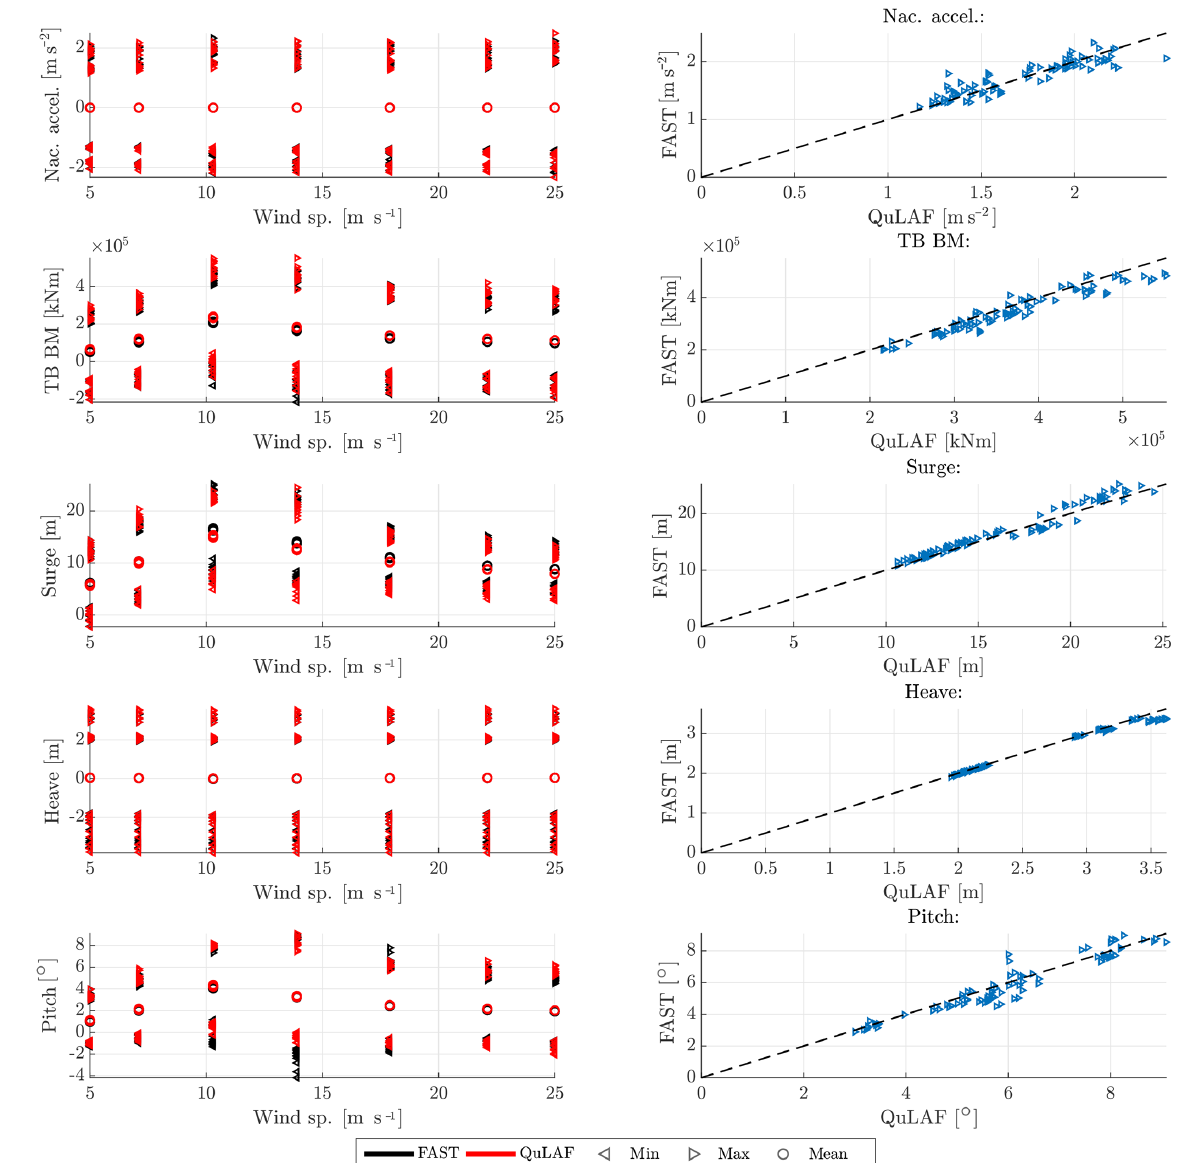
Figure 11. Response to DLC 1.6 (without viscous drag) for FAST and QuLAF. Left: min., max. and mean values for every realization as a function of wind speed. Right: maximum values for FAST as a function of the corresponding maximum values in